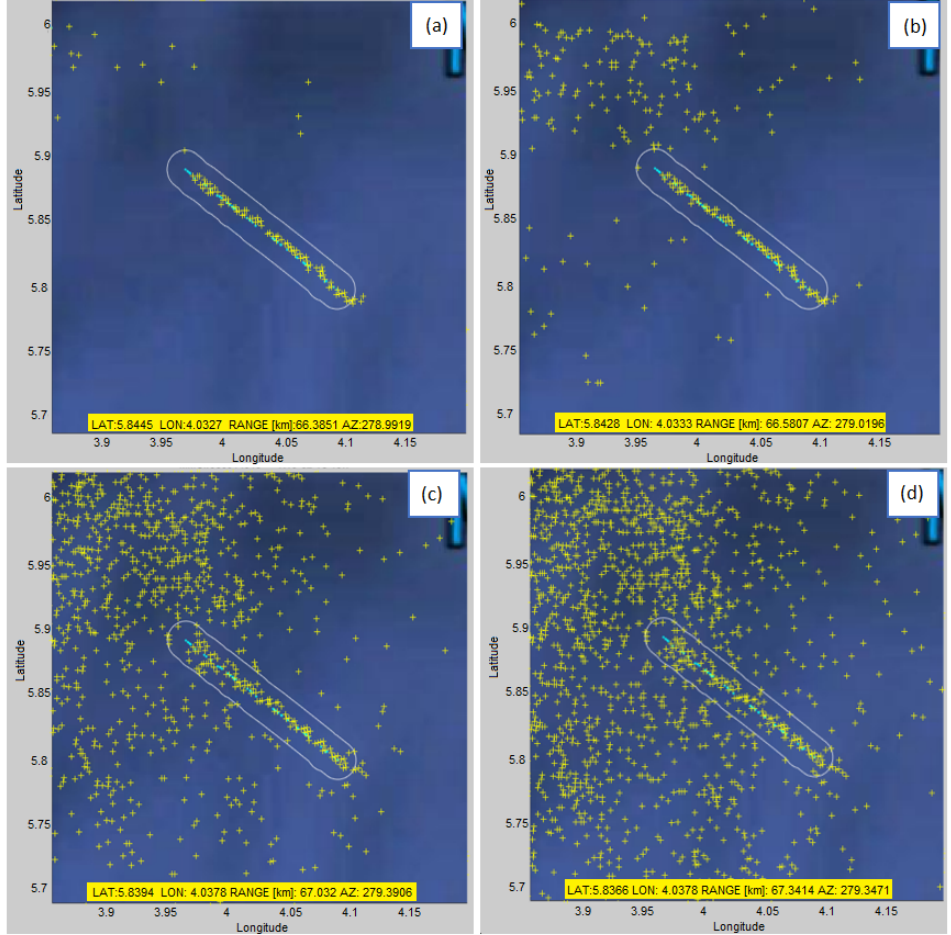
Figure 21. The display of all detections of vessel with MMSI = 636014619 (yellow markers) with AIS data as a benchmark (light blue tracks) in a time interval of 1 h (18–19 h) for different detection parameters of the proposed algorithm: ( a ) K = 5 and normalized threshold = 0.2 ( b ) K = 5 and normalized threshold = 0.1 ( c ) K = 10 and normalized threshold = 0.2 ( d ) K = 10 and normalized threshold =